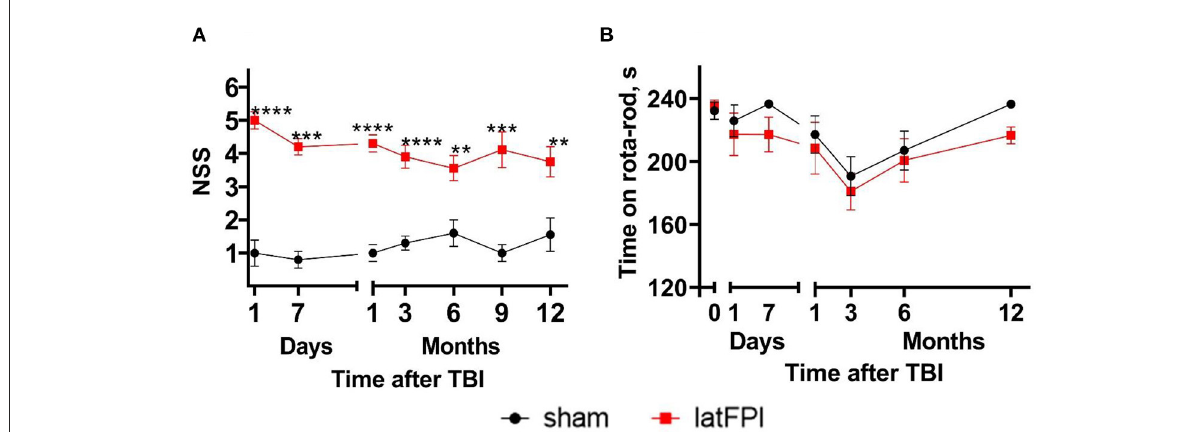
FIGURE2 Neurological status of mice following latFPI. Brain-injured animals showed significant neurological impairments up to 12 months post-injury compared to sham-operated animals (A) . Motor coordination was not affected by latFPI during the 12-month assessment period (B) . Data are